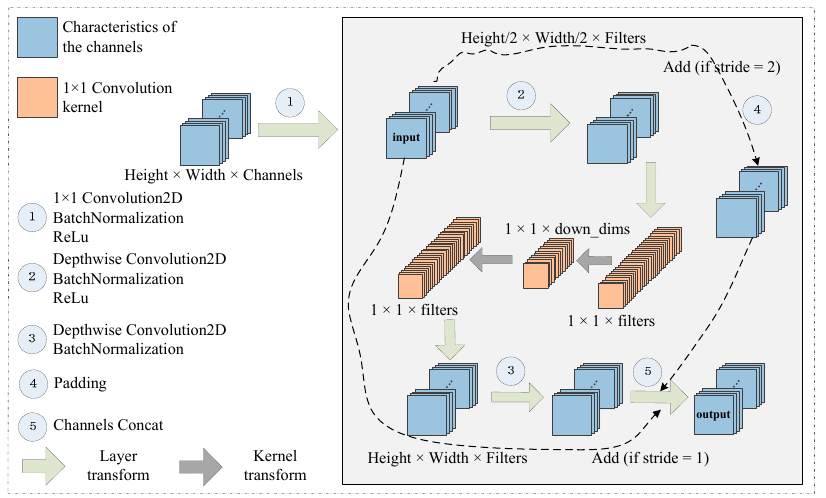
Figure 3. The Sandglass network structure.